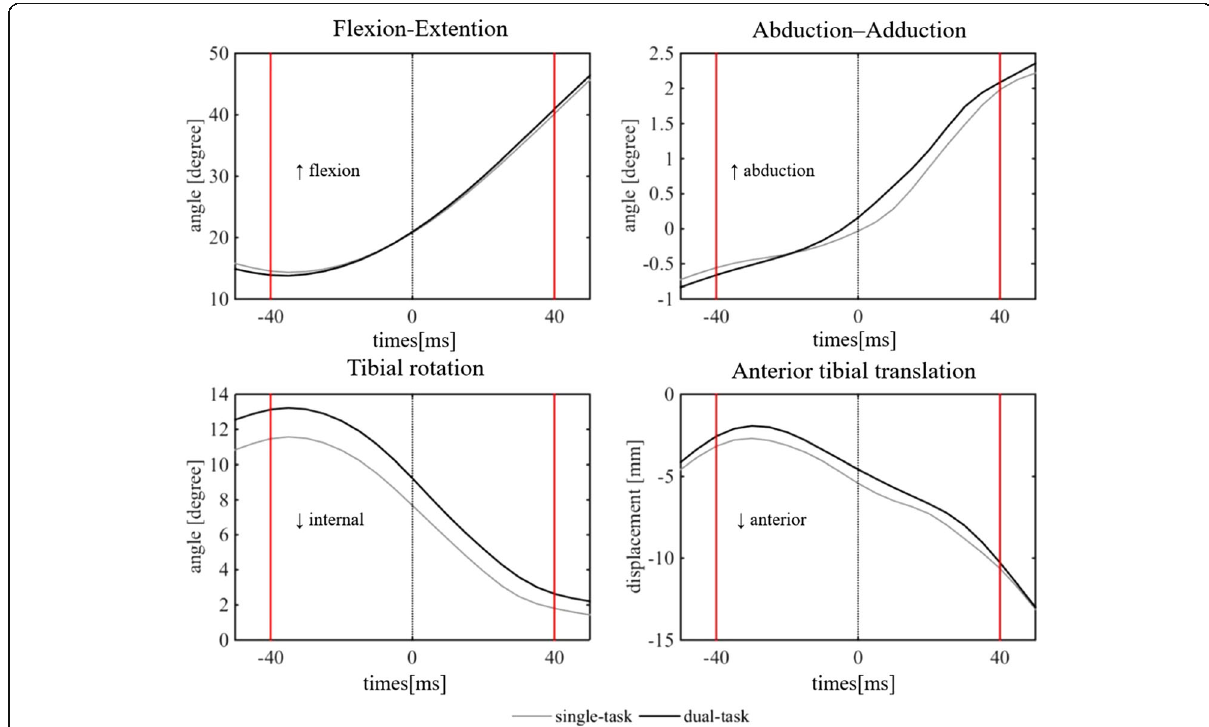
Fig. 2 Time series curves for the mean three knee angular displacements (flexion – extension, valgus – varus, internal – external rotation) and the anterior tibial translation during the 40 ms before and after initial foot contact for the two tasks (single and dual